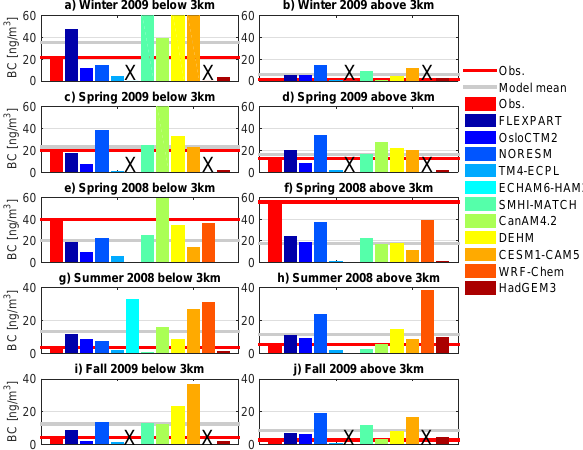
Figure 8. Median observed rBC and modeled BC mass concen- trations for the winter 2009 HIPPO (a – b) , spring 2009 PAMAR- CMiP (c - d) , spring 2008 ARCTAS/ARCPAC (e – f) , summer 2008 ARCTAS (g – h) and fall 2009 HIPPO (i – j) aircraft campaigns. The red bar and the red horizontal line show the observations, the other colored bars the various models, and the grey line shows the mean value of all model medians. Results are shown separately for mea- surements below 3km (left panels) and above 3km (right panels). Notice that the concentration scales on the ordinates are different for the individual